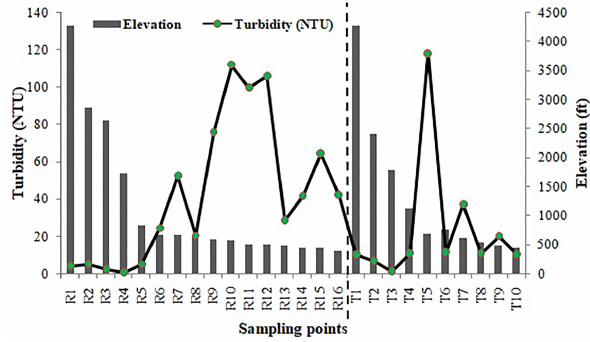
Figure 5. Spatial variation in turbidity values of the Ramganga River and its tributaries.